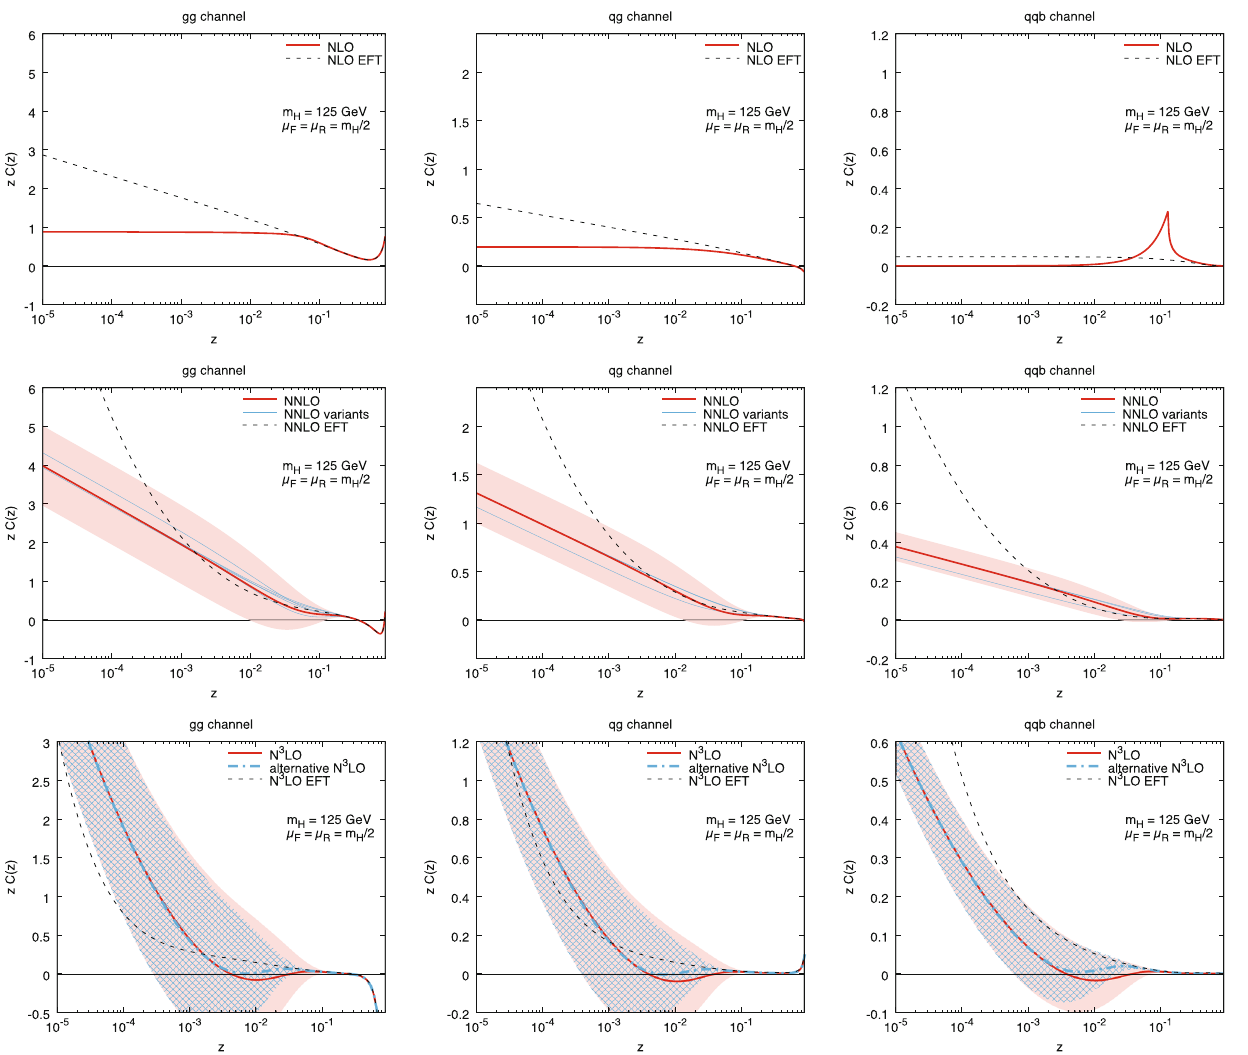
= 0andsymmetrizingthevariation.AtNNLOsomevariantsofthe A ( k ) 0 construction based on both Eqs. (3.12) and (3.16) with a = − 1 , 0 , 1 are shown in solid light blue. At N 3 LO the alternative implementa- tion Eq. (3.17) is also shown in dot-dashed blue. The Higgs mass is m H = 125 GeV, the top mass m t = 173 GeV, and the scales are μ = μ = m / 2 H F R